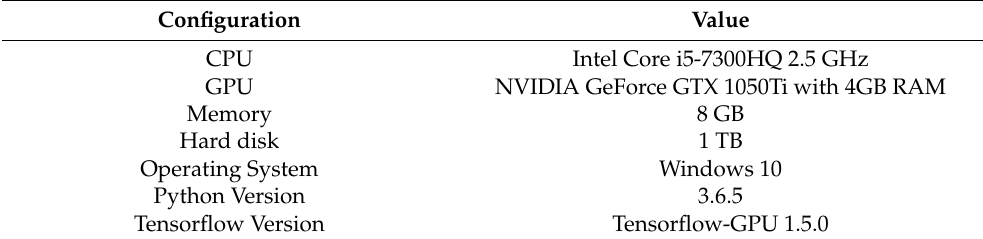
Table 2. Hardware and software configurations used in the